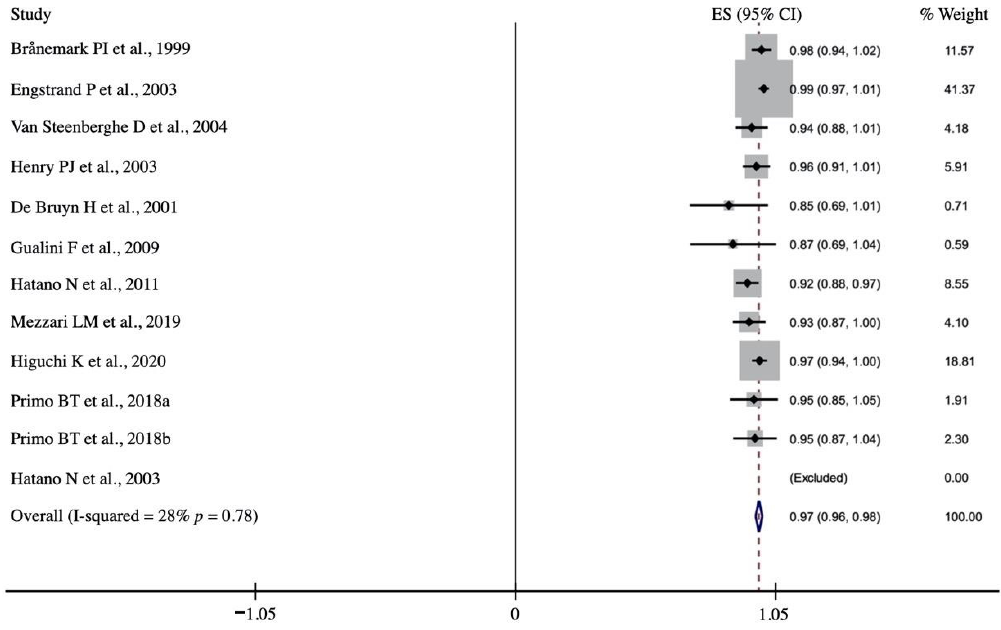
Figure 2. Forest plot. Implant survival rate after 1–6-year follow-up.